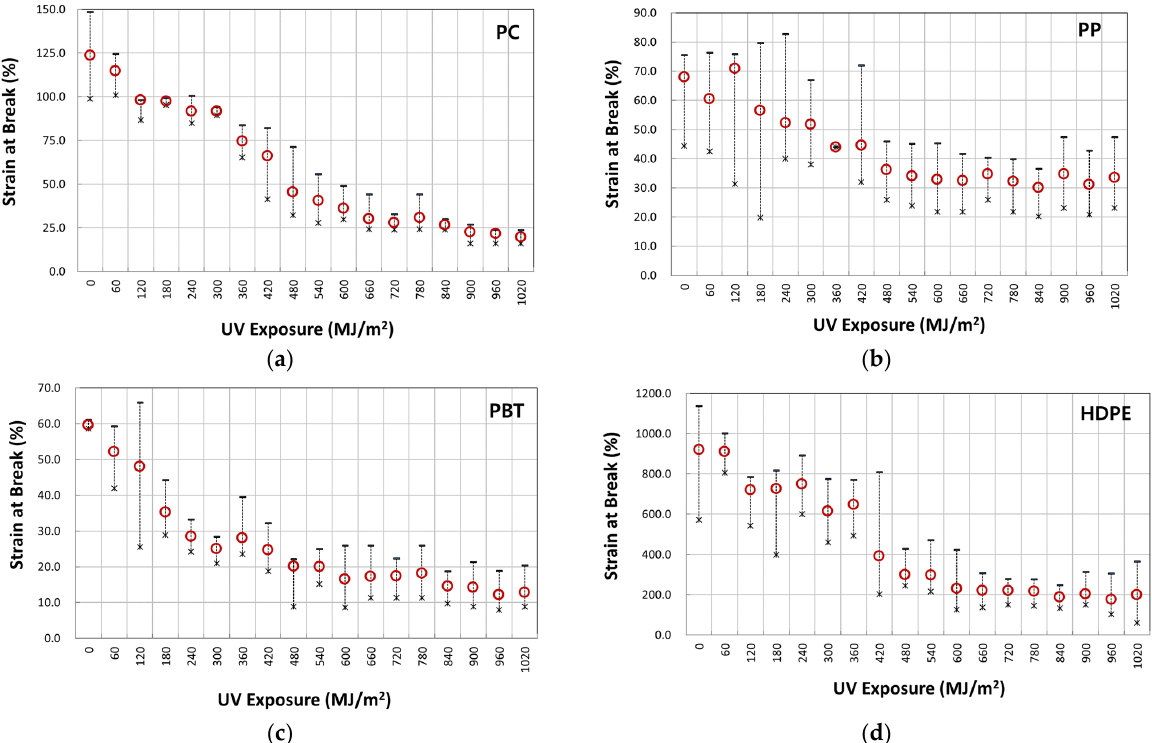
Figure 10. Variation of fracture strain with UV irradiation dose: ( a ) PC; ( b ) PP; ( c ) PBT; and ( d ) HDPE.